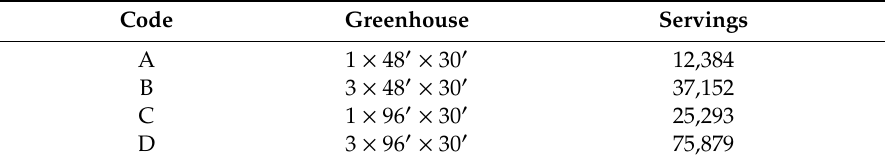
Figure 4. Energy demand for a single 96´ × 30´ greenhouse. Table 9. Vegetable servings per number of greenhouses.